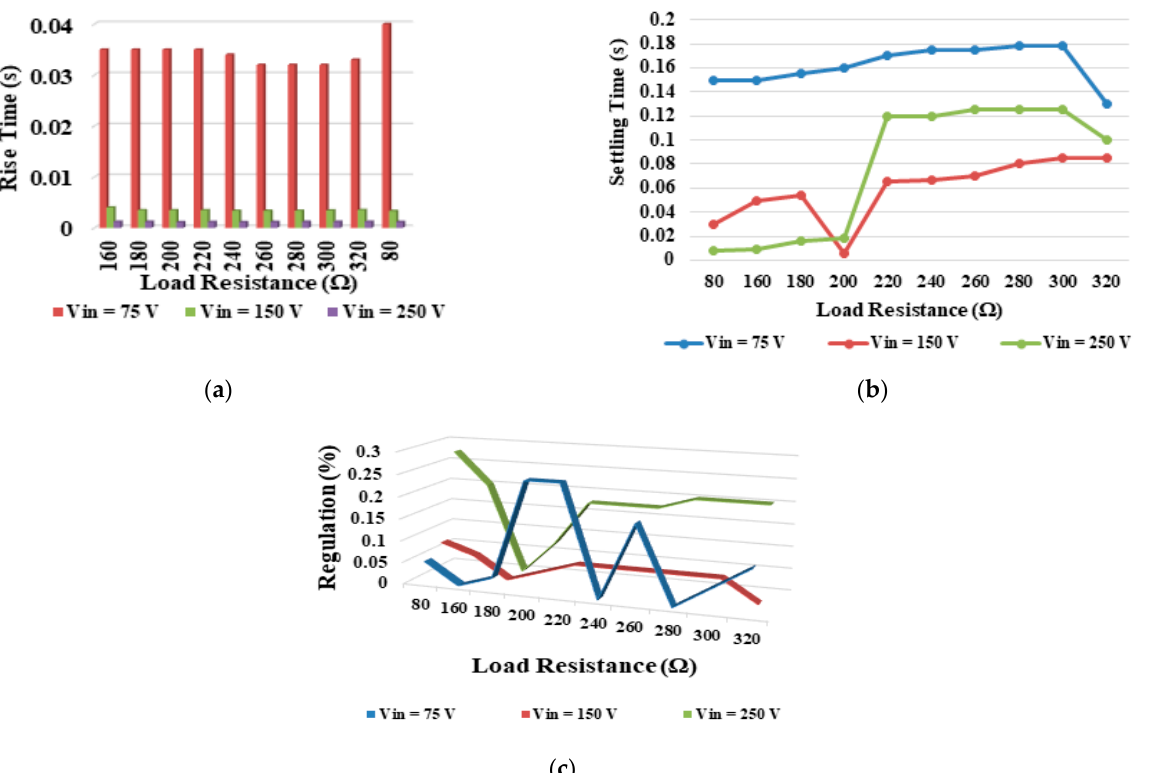
Figure 15. Performance analysis of HG-SIQBC: ( a ) rise time; ( b ) settling time ; ( c ) regulation.